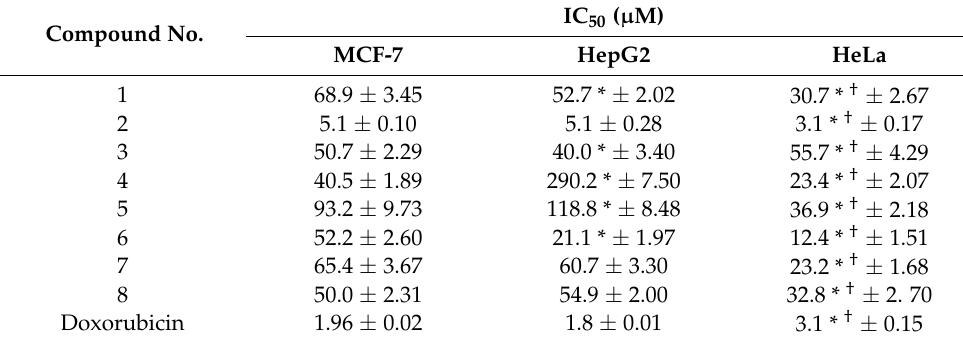
Table 3. Cytotoxic effects of compounds 1 – 8 isolated from Rhazya stricta . Compound